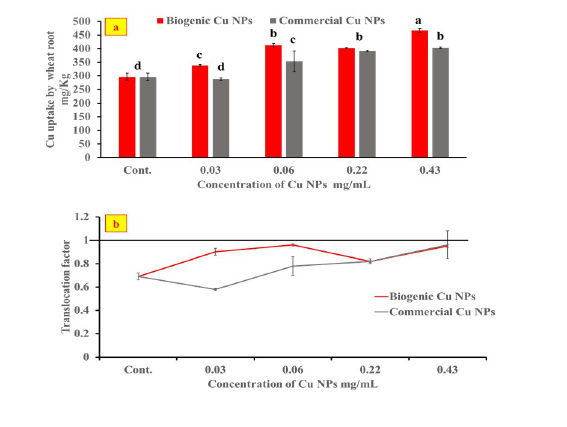
Fig 8. Cu uptake in wheat seedlings (a) and Translocation factor of wheat seedlings